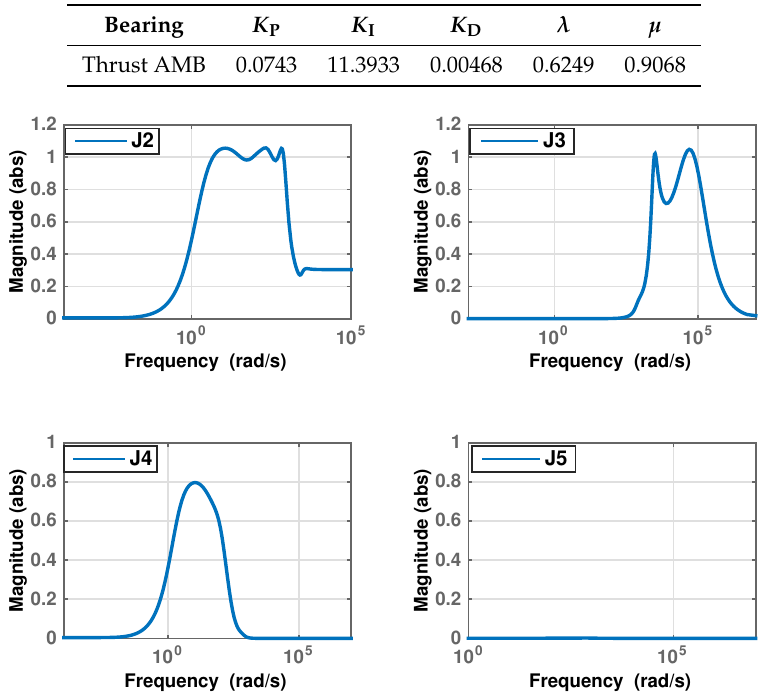
Figure 28. Magnitude of the objective functions under the FOPID